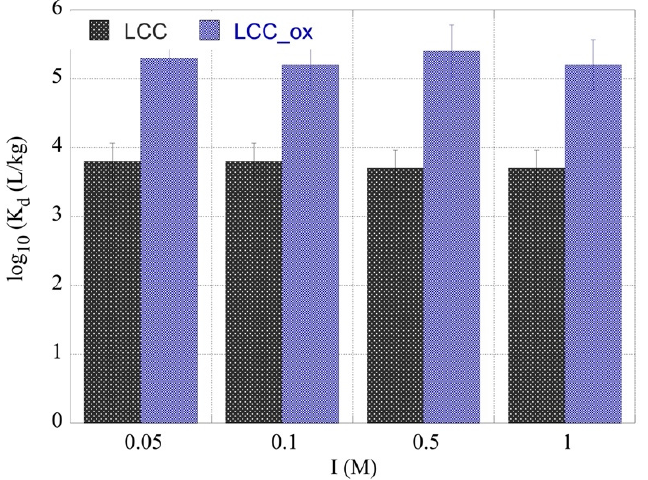
Figure 5. The K d values for the U(VI) sorption by two different types of biochar fibers (LCC and LCC_ox) as a function of ionic strength. [U ‐ 232] = 8.6 × 10 − 14 mol/L, biochar mass = 0.01 g, pH 4 and LCC_ox) as a function of ionic strength. [U-232] = 8.6 × 10 − 14 mol/L, biochar mass = 0.01 g, pH 4 ambient conditions. and ambient